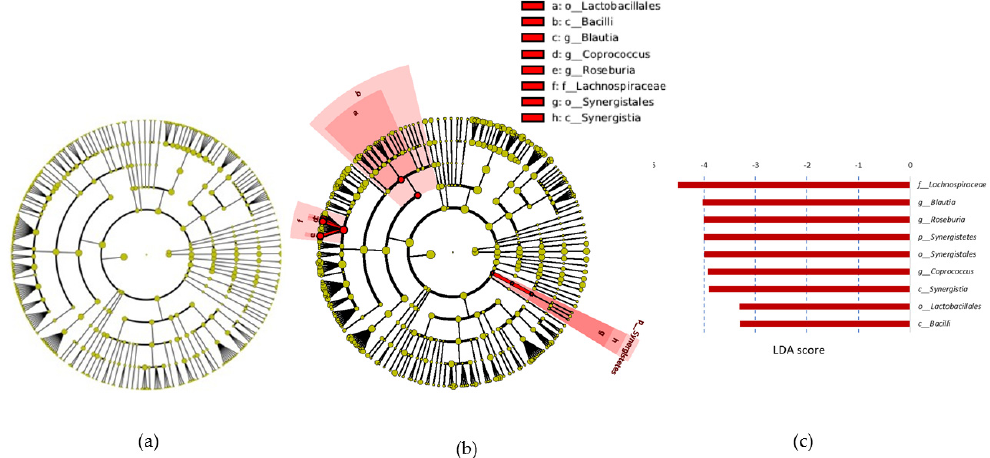
Figure 1. Cladograms and LDA (Linear Discriminant Analysis) score generated by LEfSe (Linear Discriminant Analysis Effect Size) indicating differences in bacterial taxa after CHO (maltodextrin group) and PRO (protein group) supplementation. The central point represents the root of the tree (bacteria), and each ring represents the next lower taxonomic level (phylum through genus). The diameter of each circle represents the relative abundance of the taxon. Red indicates those bacterial taxa that were significantly less abundant after 10 weeks of PRO supplementation. ( a ) Differences in bacterial taxa between (t0) and (t10w) in CHO group; ( b ) differences in bacterial taxa between (t0) and (t10w) in PRO group; ( c ) PRO LDA score; only the taxa meeting a significant LDA threshold value of >2 are shown. The PRO ‐ reduced taxa are indicated with a negative LDA score.